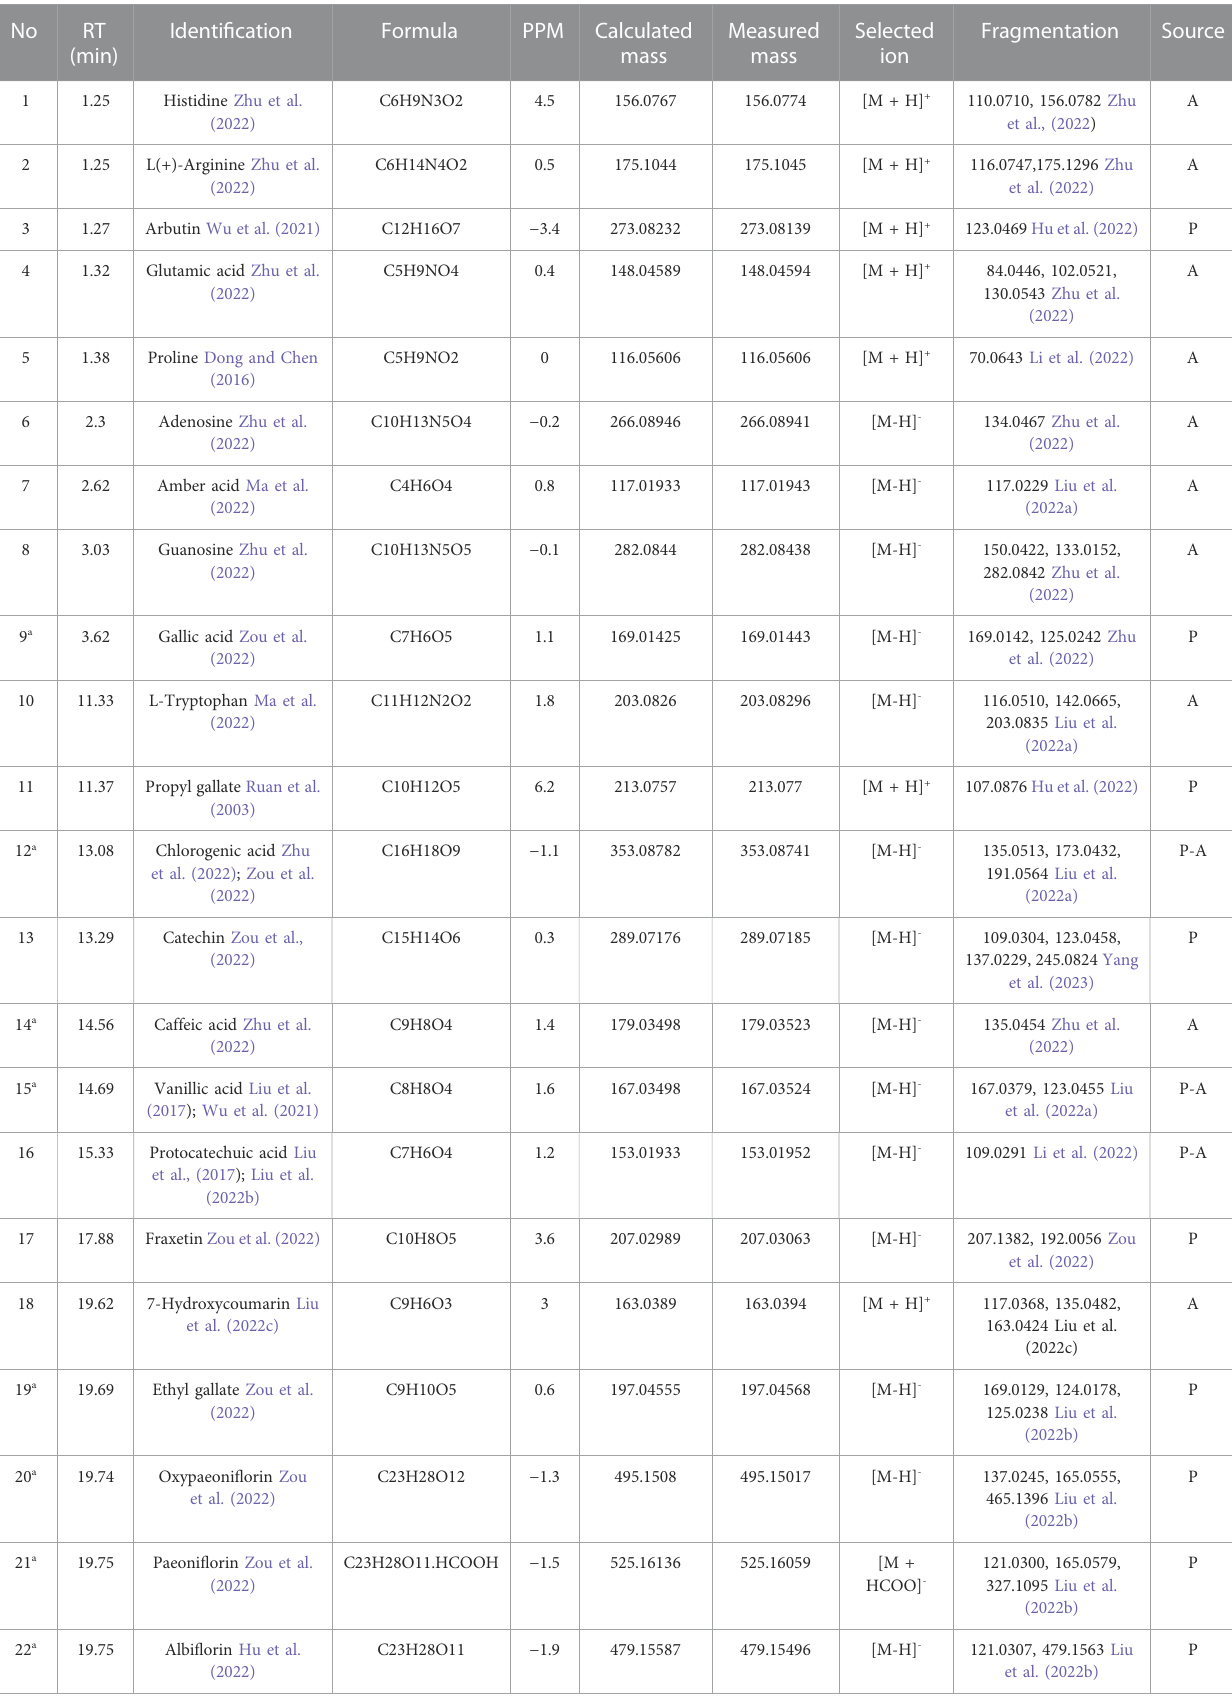
TABLE 1 Identi fi cation of the chemical components of the P-A drug pair. No RT Identi fi cation Formula PPM Calculated (min)